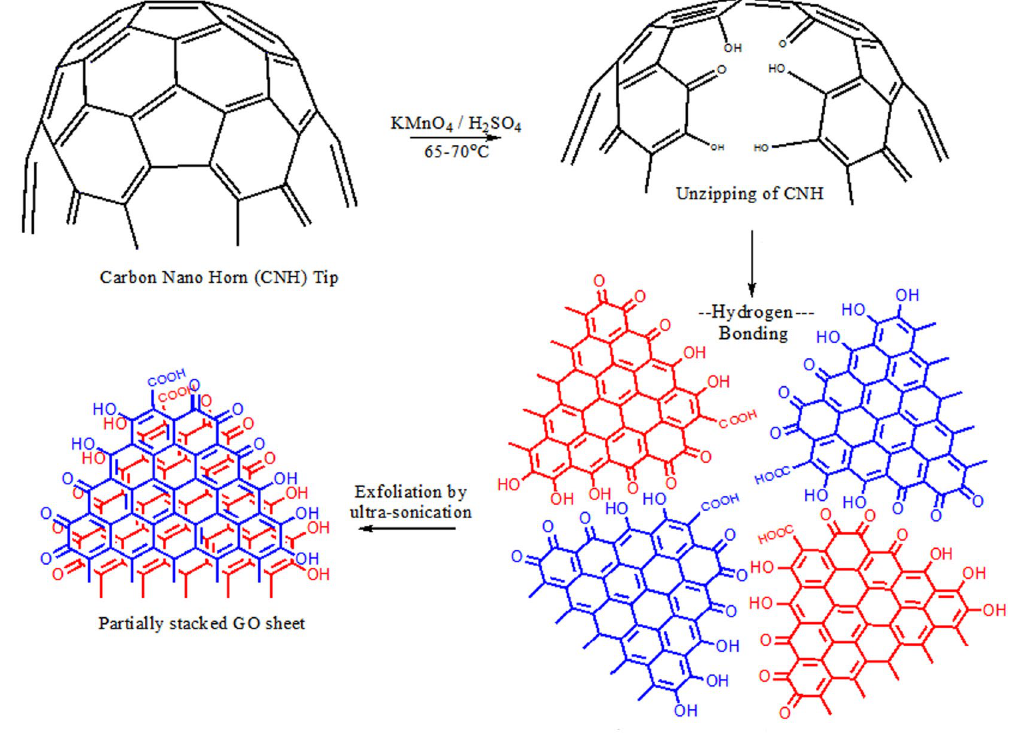
Figure 1. Schematic representation of the process of unzipping of CNHs into homogenous GO sheets with uniform morphology and their further exfoliation by ultrasonication to thin GO